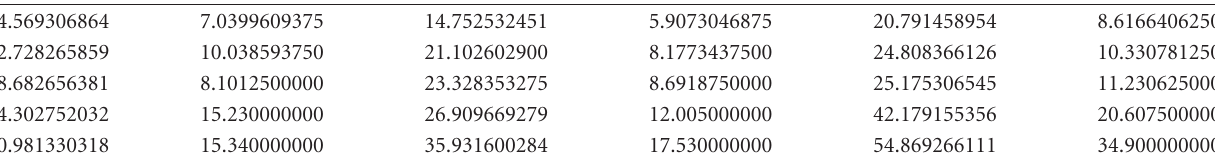
Table 1: Fi matrix.